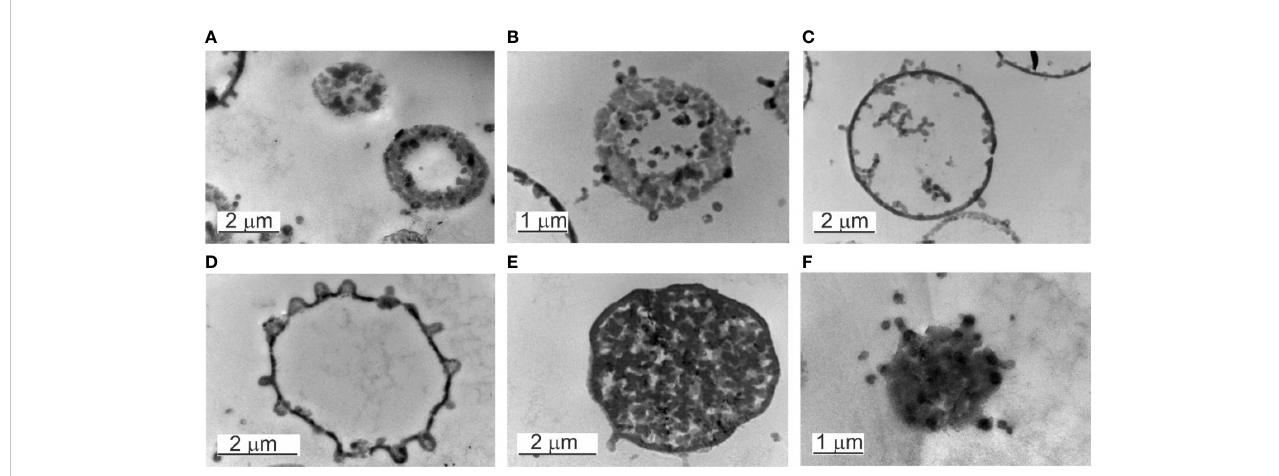
FIGURE 6 Electron transparent and electron-dense bodies. (A – D) Electron transpatent bodies. (B) The burst of an electron-transparent body. (C, D) The elementary bodies growing within the “ mother cell ” can leave at any site of the cell surface. (E) Electron-dense body in a growth phase. The cytosol is full of progeny cells. (F) The burst of an electron-dense